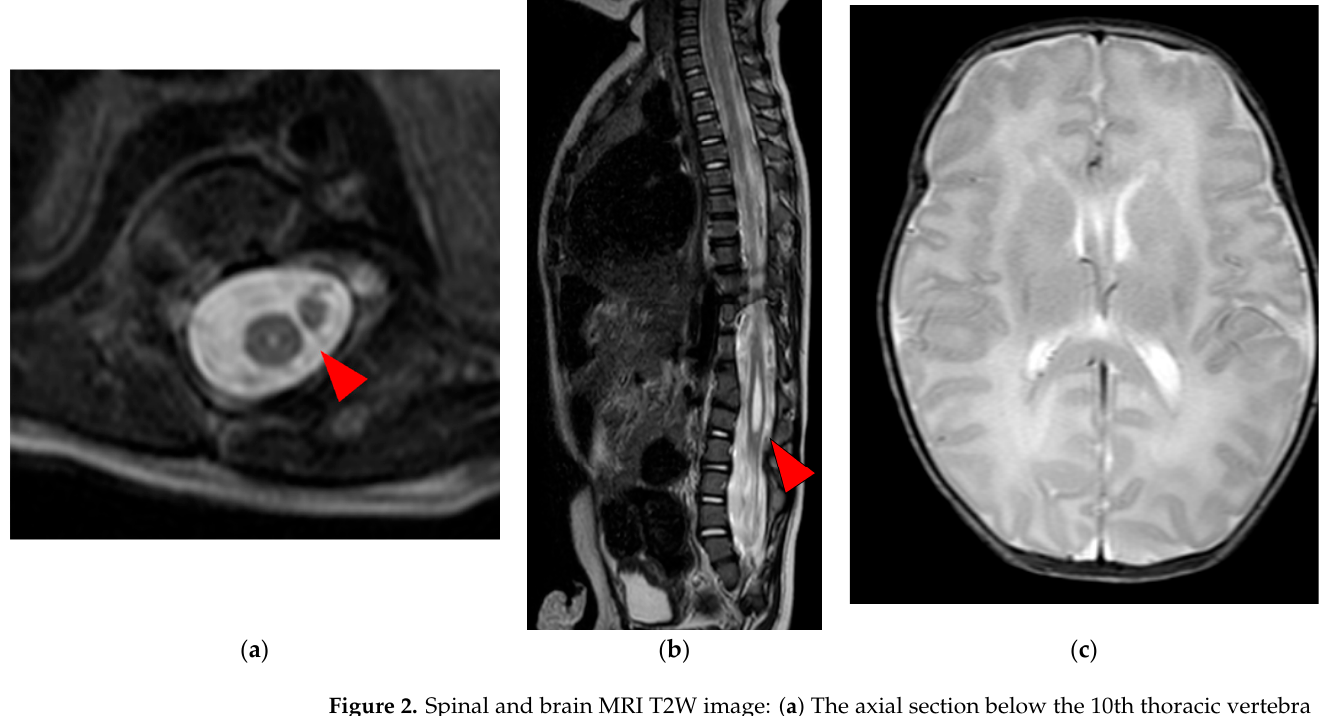
Figure 2. Spinal and brain MRI T2W image: ( a ) The axial section below the 10th thoracic vertebra displaying the separated spinal cord within a single dural sheath and syringomyelia (red arrow); ( b ) The sagittal section below the 10th thoracic vertebra displaying the syringomyelia (red arrow); ( c ) The axial view of the brain presented no gross abnormalities; MRI, magnetic resonance imaging; T2W, T2 weighted.